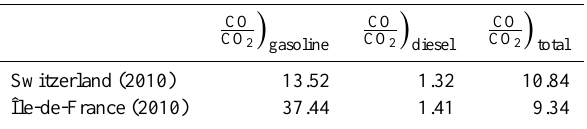
Table 4. CO to CO 2 ratios (ppbppm − 1 ) for gasoline and diesel con- tributions in Switzerland and in Île-de-France, using annual emis- sion